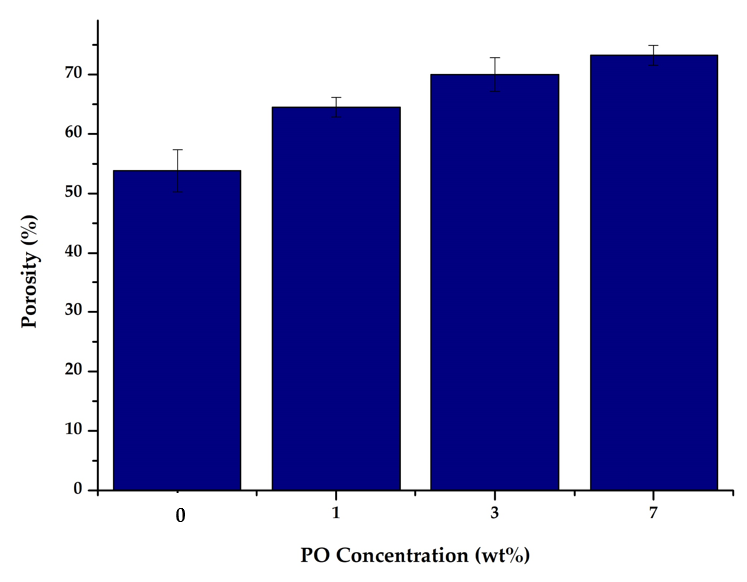
Figure 4. Membrane Figure 4. Membrane porosity.